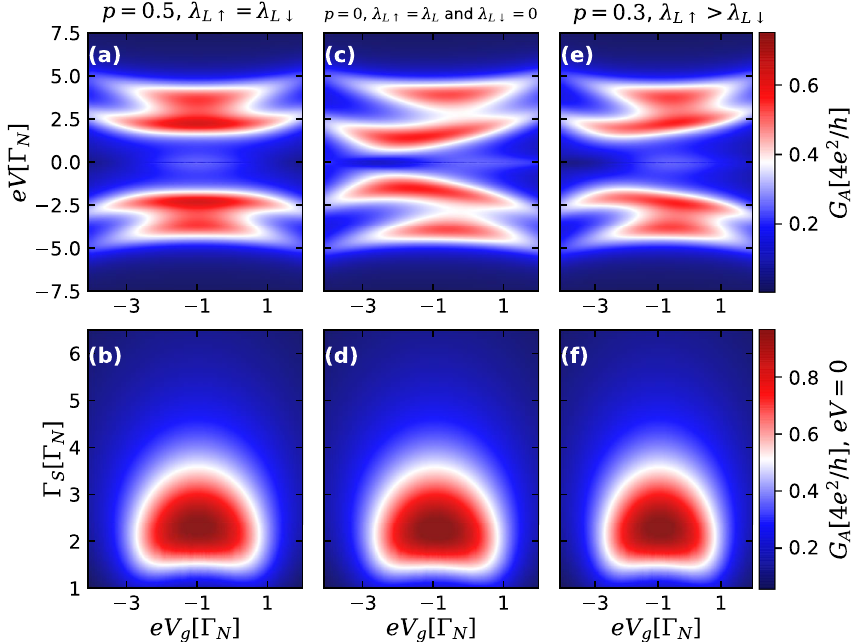
Figure 4. Upper panels: Color scale plots of the Andreev conductance G A [Eq. (5)] as a function of bias voltage eV and QD gate voltage eV g , for the case of overlapping MBSs well-localized at edges of the TSC (cid:31) 0.05 Ŵ 0 ) and Ŵ 3.0 Ŵ section ( ε M N , R σ = S = N . Panels ( a ), ( c ) and ( e ) correspond to the cases of spin- = independent (